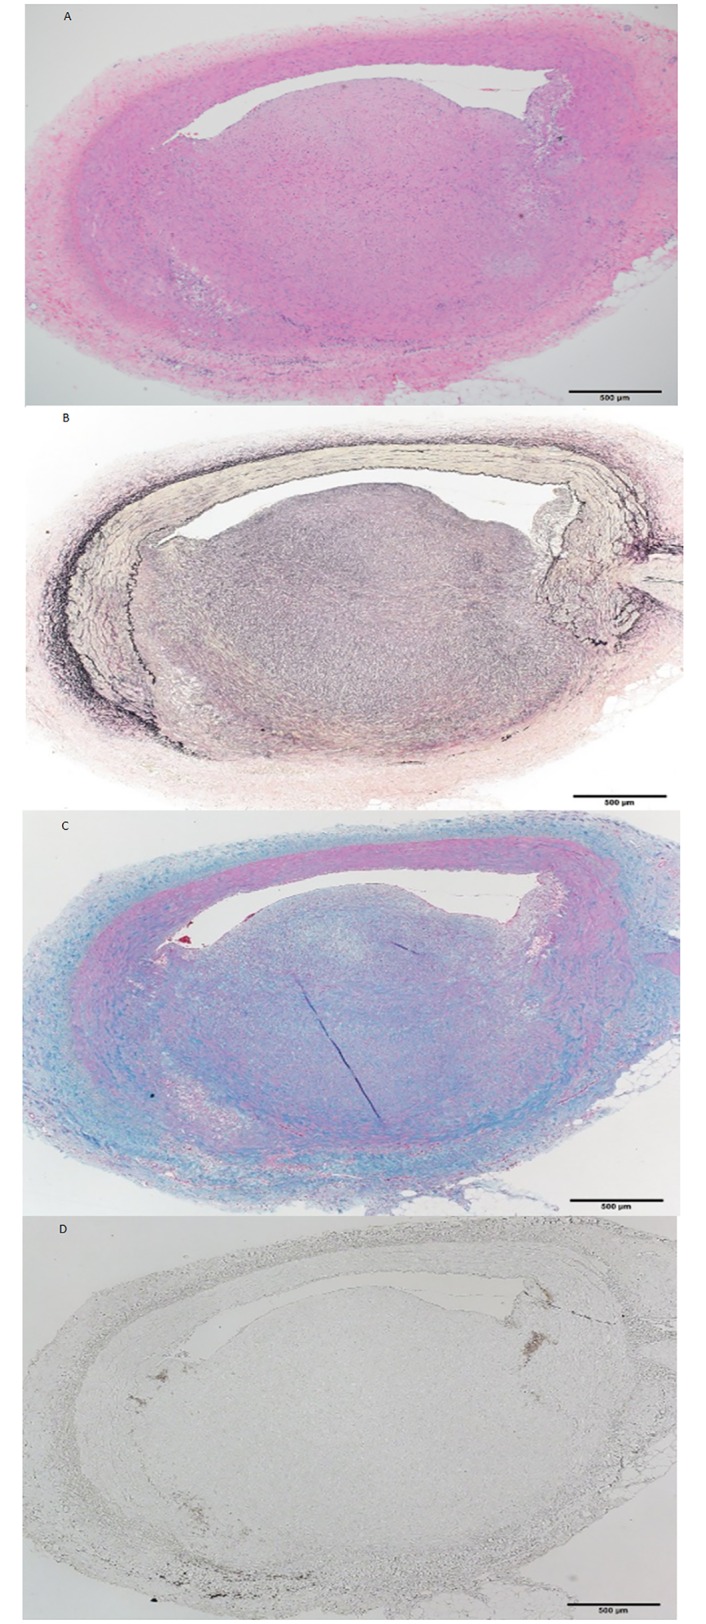
(A-D): Coronary arterial lesion in LDLR-KO pig at 12 weeks.Intima has further thickened and cell components have changed. Numbers of inflammatory cells have decreased and fibrous components have become predominant. A, hematoxylin-eosin; B, Elastica van Gieson; C, Azan; D, cathepsin S immunohistochemical staining. Scale bar, 500 μm.